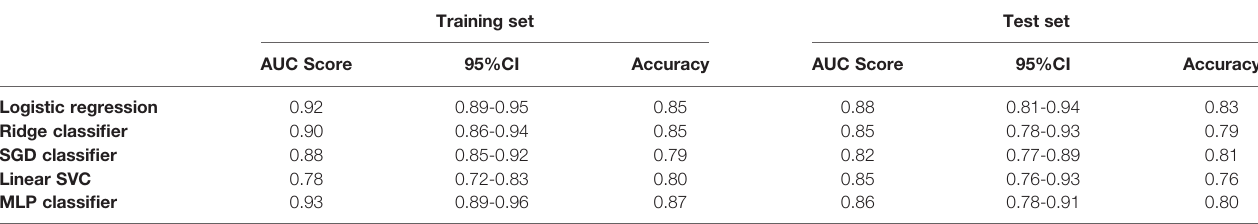
TABLE 2 | Diagnostic performance of classi fi ers in the training and test groups.